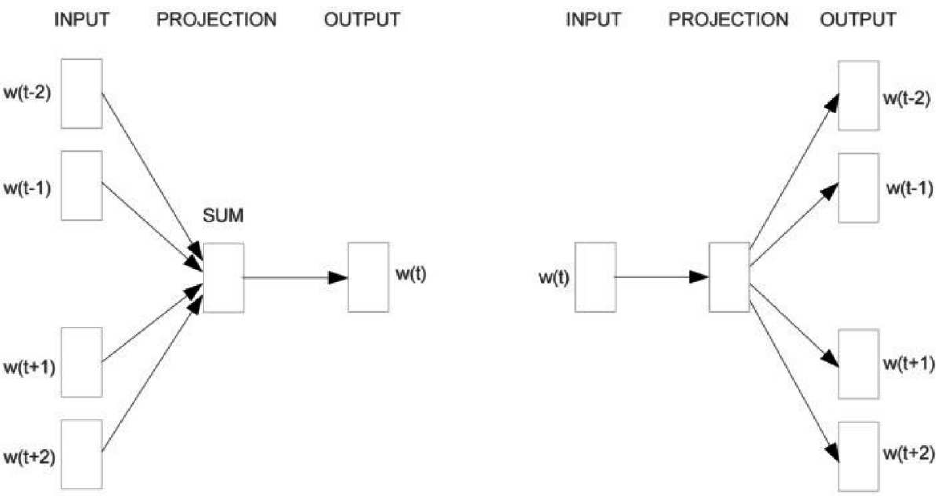
Fig. 1 CBOW model and